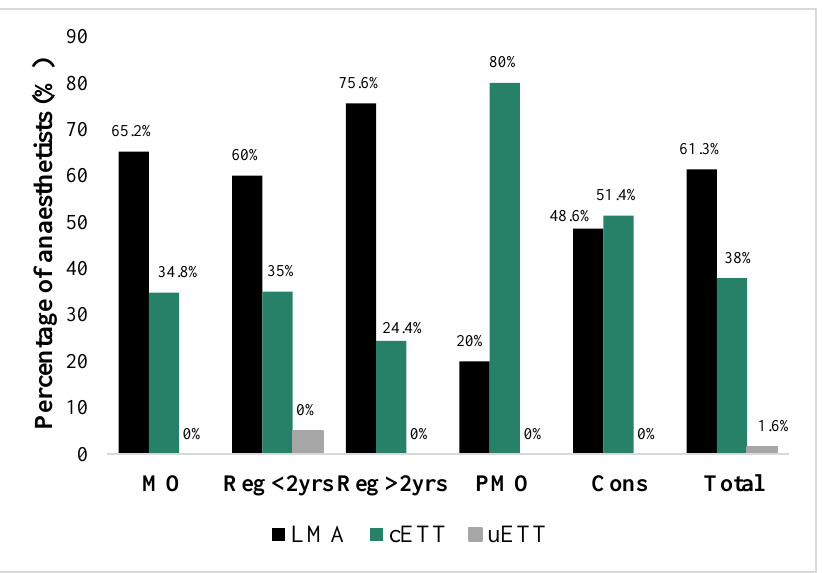
Figure 6. Choice of airway for forearm fracture MUA by grade of anaesthetist.